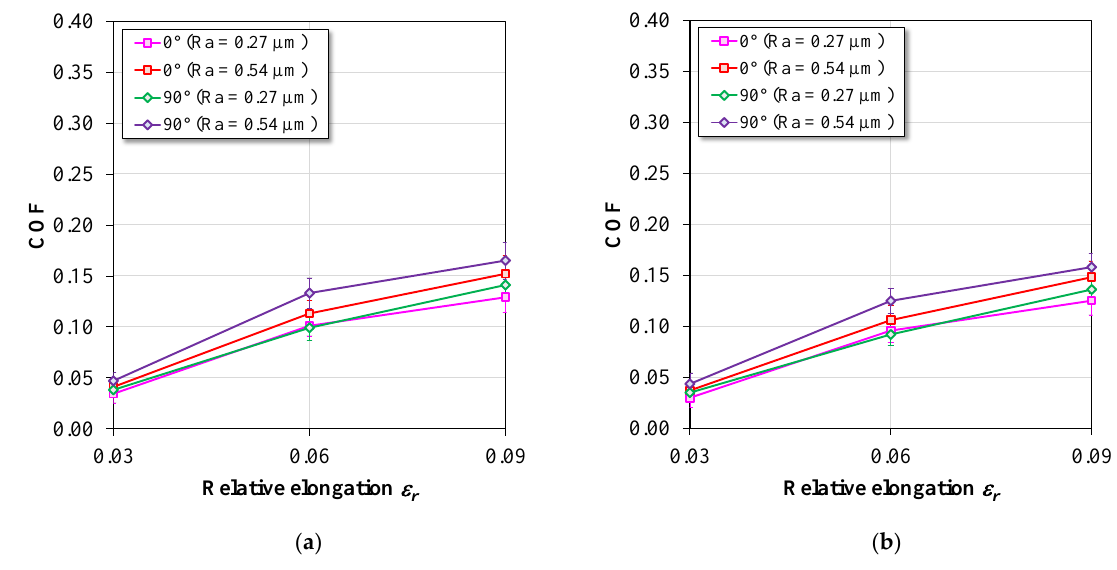
Figure 10. COF values obtained in the BUT test: ( a ) dry contact and ( b ) lubricated contact.